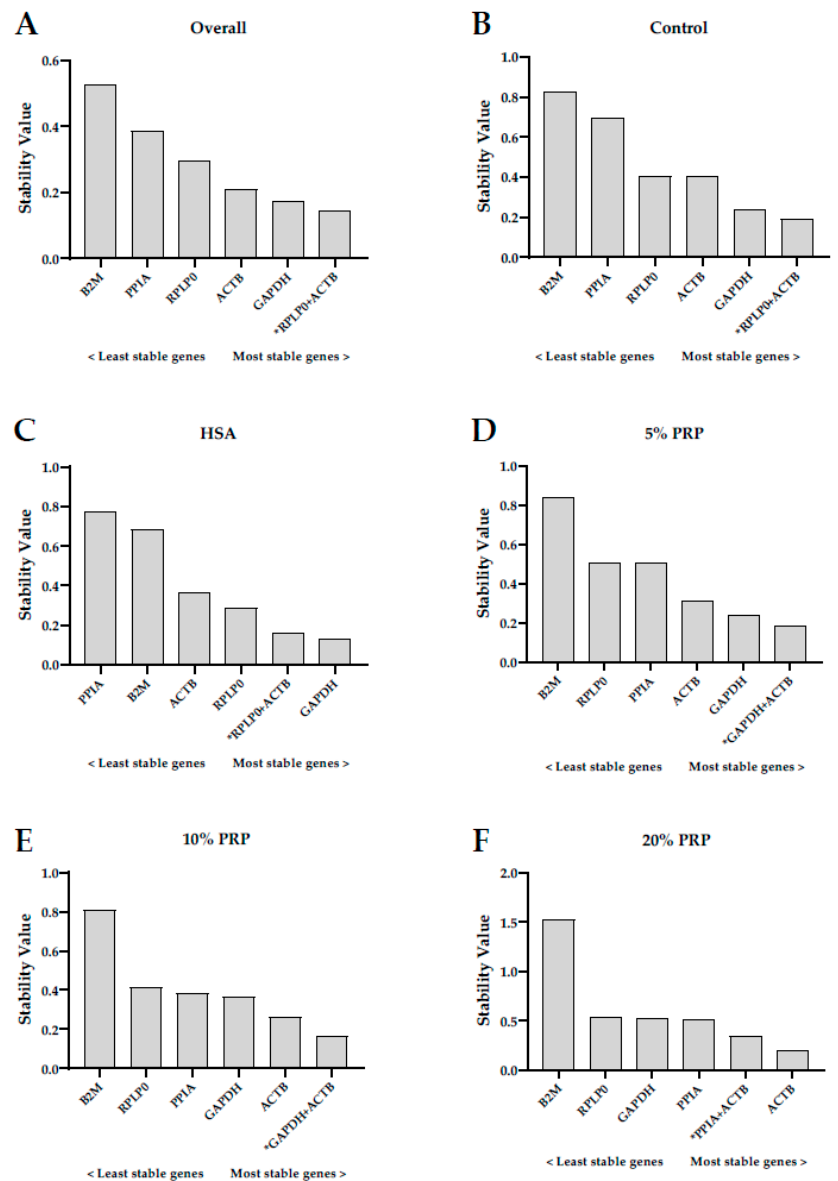
Figure 2. Evaluation of gene expression stability of GAPDH , B2M , RPLP0 , ACTB , and PPIA by the NormFinder software in pieces of ovarian cortex after 24 h incubation with different serum-derived products: ( A ) overall results; ( B ) control treatment; ( C ) culture medium supplemented with human serum albumin (HAS); ( D – F ), culture medium supplemented with increasing concentrations of platelet-rich plasma (PRP; ( D ) 5% PRP; ( E ) 10% PRP; and ( F ) 20% PRP). The genes are ranked from the least ( left ) to the most ( right ) stable. * Best combination of two genes.